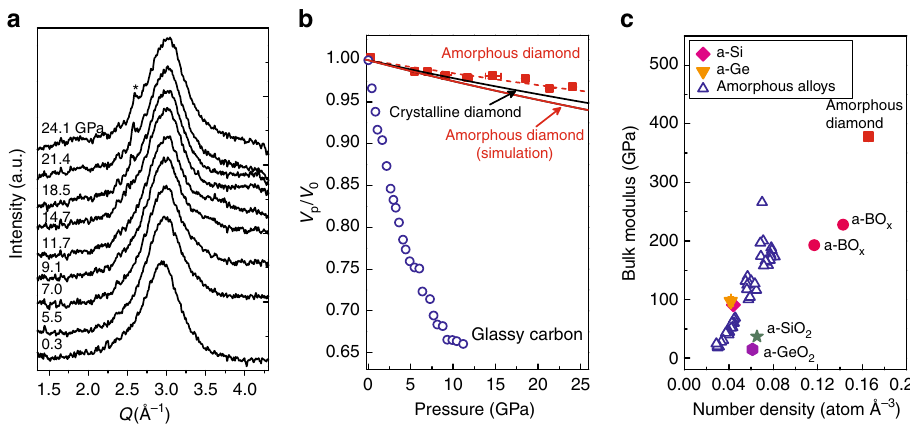
Fig. 3 In situ high-pressure XRD of amorphous diamond. a XRD patterns of the amorphous diamond sample as a function of pressure. The X-ray wavelength is 0.4066 Å. Diffraction peaks from the pressure medium helium are marked by symbol * . b Pressure vs. fractional volume changes for glassy carbon ( circles ) 25 , crystalline diamond ( black solid line ) and amorphous diamond ( squares for experimental results, red solid line for simulation results). The dashed line is a second-order BM-EOS fi t to the experimental data. The volume change of amorphous materials is estimated by assuming a cubic power law between the volume and the inverse position of the diffraction peak (q − 1 ). The peak position was derived by fi tting the diffraction peaks to a Gaussian function. c Bulk moduli and atomic number densities of amorphous diamond, a- Si 10 , a -Ge, SiO 2 glass, GeO 2 glass 35 , amorphous BO x 32 , and amorphous alloys (metallic glasses) 34 . The error bars of pressures were estimated by measuring pressure before and after each XRD